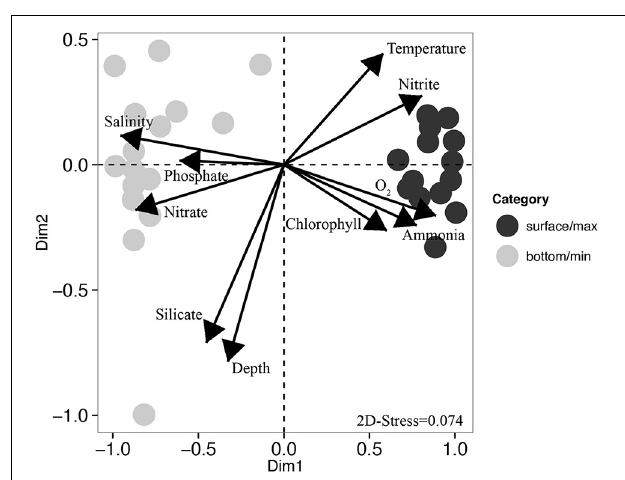
FIGURE 5 | Non-metric multidimensional scaling (nMDS) ordination. Dark circles represent samples collected either at the surface or at the oxygen maximum, and gray circles represent samples collected either at the oxygen minimum or close to the seafloor. Each arrow represents one environmental gradient significantly correlated to the ordination (envfit, p < 0 . 05). The arrow points to the direction of the most rapid change in the environment (direction of the gradient) and its length is proportional to the correlation between ordination and environmental variable (strength of the